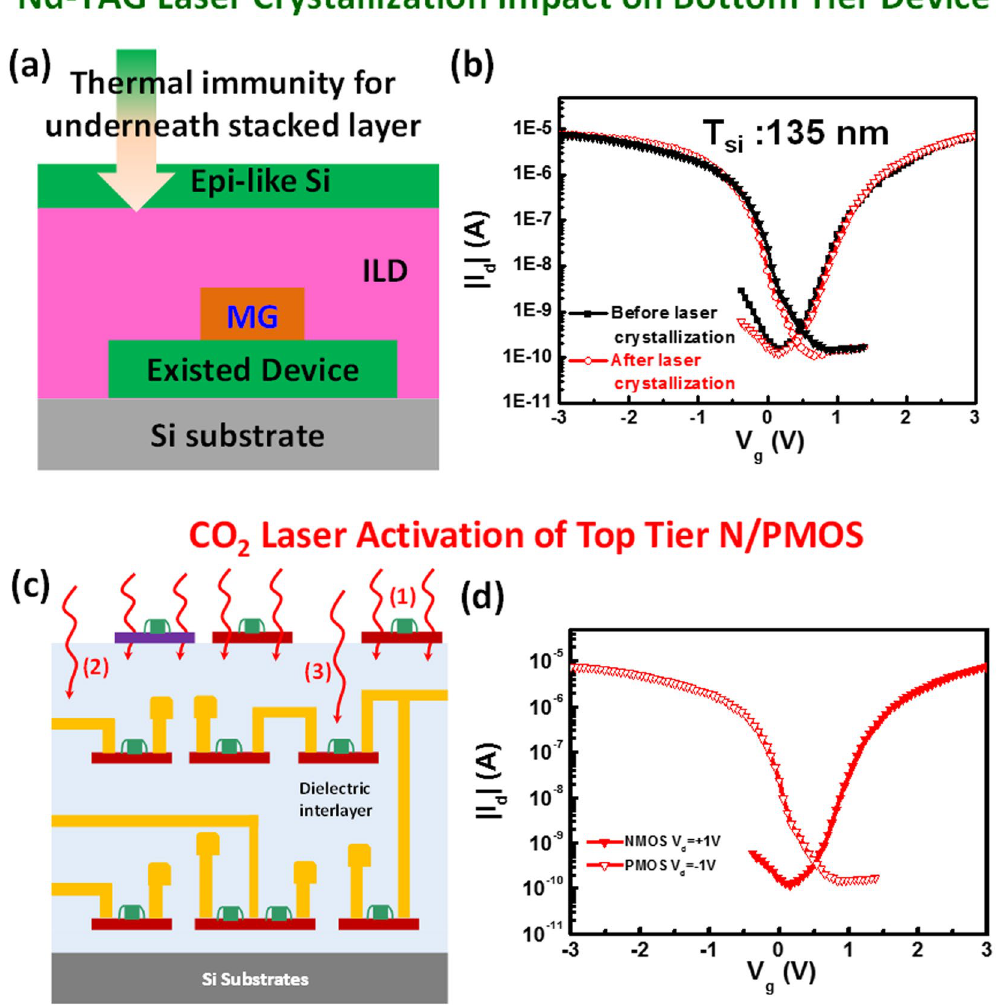
Figure 4. ( a ) A schematic of top tier laser crystallization on bottom tier device. ( b ) The corresponding I d -V g behaviors of the a-Si thin film with a critical thickness > 135 nm before and after the top tier laser crystallization. ( c ) A schematic of interactions between CO 2 laser and devices, including top tier source/drain regions effective activation, bottom tier metallization reflection and defects repair of bottom tier channels. ( d ) The corresponding I d -V g behaviors of top tier device after the activation process by the CO 2